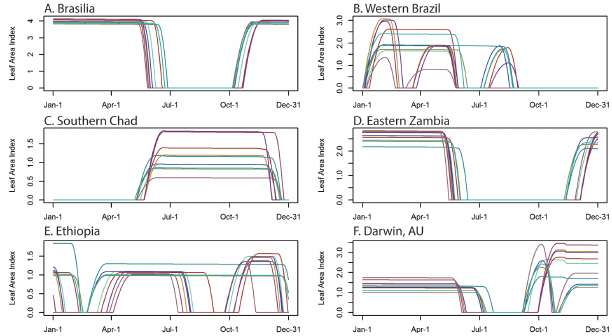
Figure 5. Illustration of Latin hypercube (LH) variable exploration analysis results as with Fig. 4 – here each line represents one sim- ulation from 1 year of the LH analysis with the additional rainfall trigger.